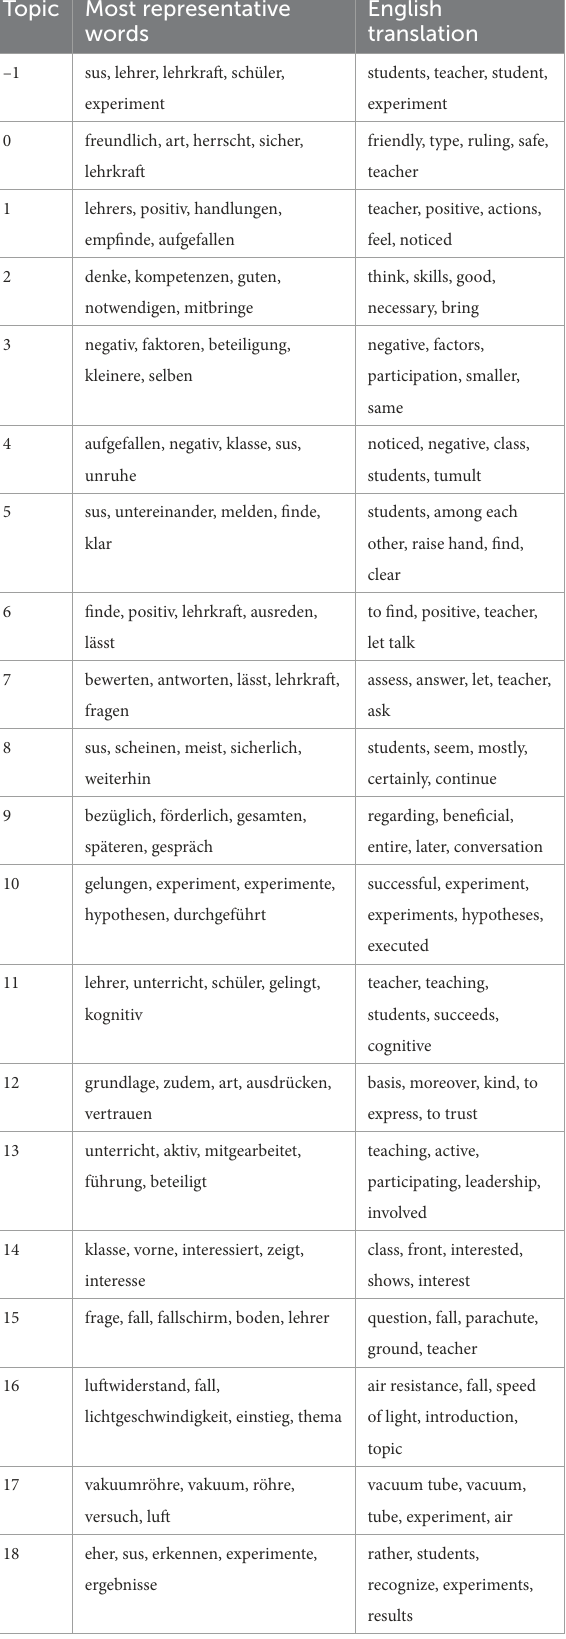
TABLE 4 Five most representative words for each extracted